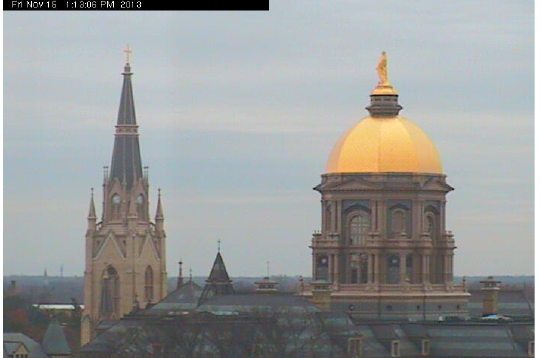
Figure 10. Sample property prediction results and the ground truth. (Predicted values, ground truth)s of temperature, humidity, visibility, and wind speed are: (21 ◦ C, 19 ◦ C), (26%, 33%), (10 miles, 10 miles), and (22 miles/h, 19 miles/h), respectively.